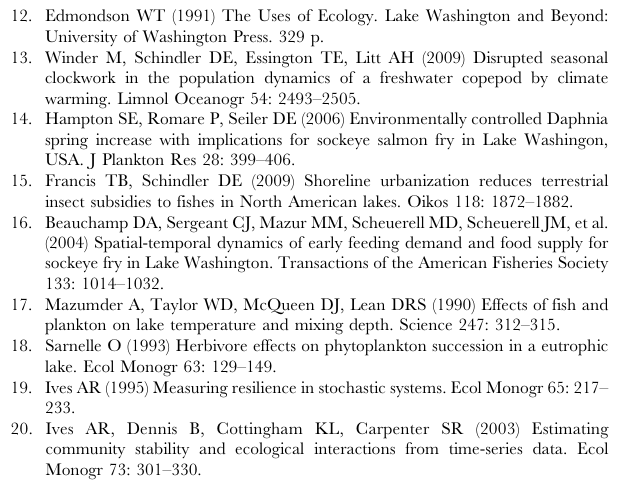
Figure S2 Time series of all community interactions. Interaction coefficients estimated for the Lake Washington time series with a mwMAR model, using an 84-month window. Figures show per-capita effects of plankton guilds in columns on plankton guilds in rows. Diagonal figures represent self-effects, or density- dependent effects on abundance.